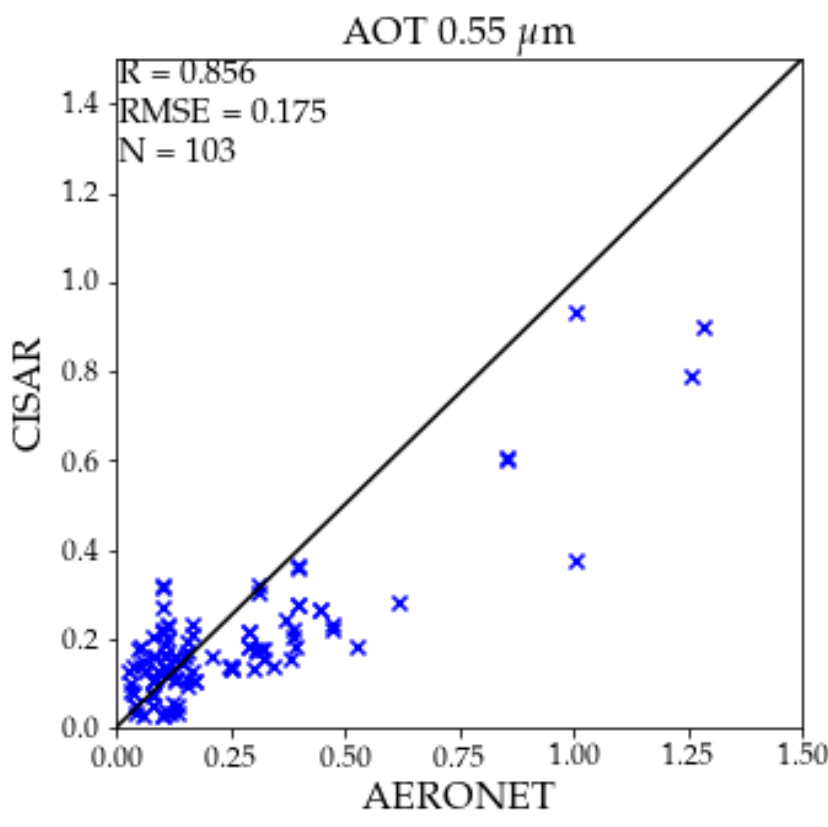
Figure 12. Scatterplot between the AOT at 0.55µm retrieved by CISAR (y axis) and delivered by the AERONET V3 L2 product (x axis). Correlation (R), root mean square error (RMSE), and number of CISAR-AERONET collocations within a 30 min window (N) are shown in the ±